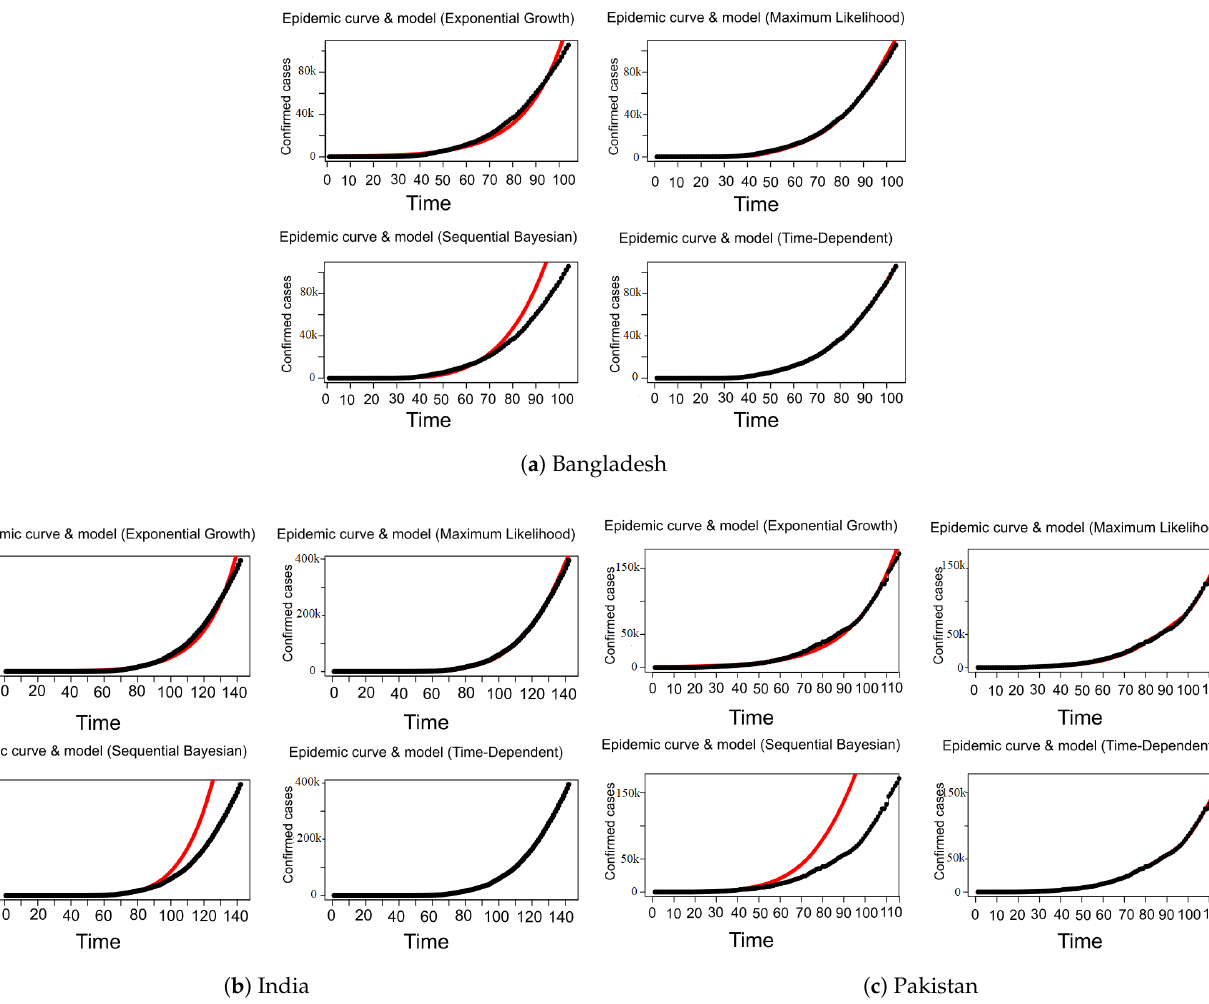
Figure 8. Models (EG, ML, SB, TD) fitting on COVID-19 confirmed